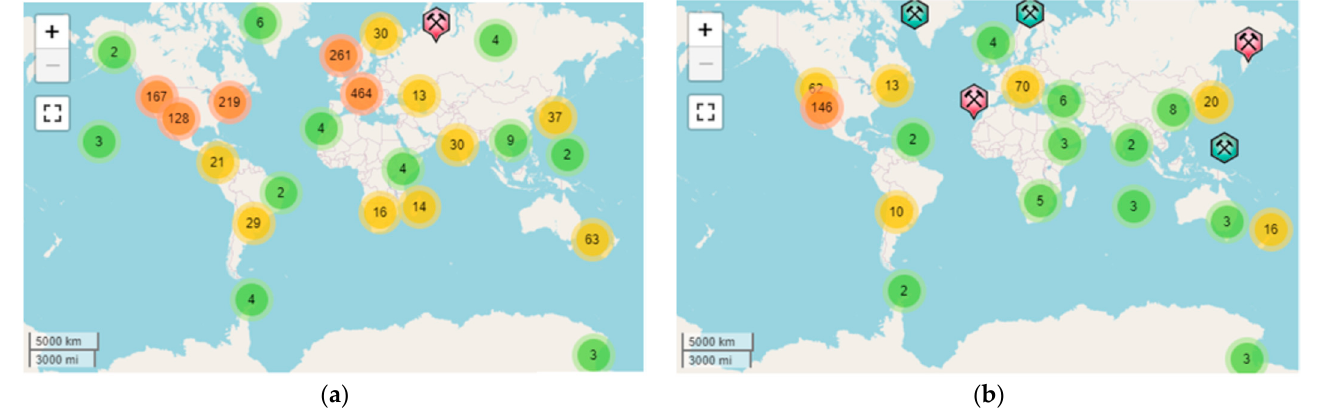
Figure 1. Worldwide map of localities for heulandite ( a ) [50] and clinoptilolite ( b ) [51] zeolite deposits. The numbers in circles correspond to the number of different deposits nearby, the color of the circles consistent with the number of deposits (from smaller to larger: green < yellow < orange).